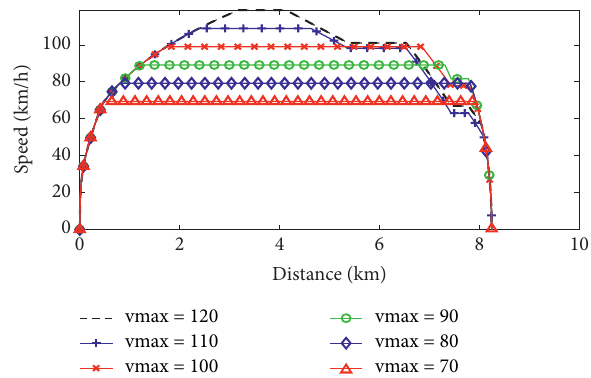
Figure 4: Optimized speed profiles for various maximum speeds